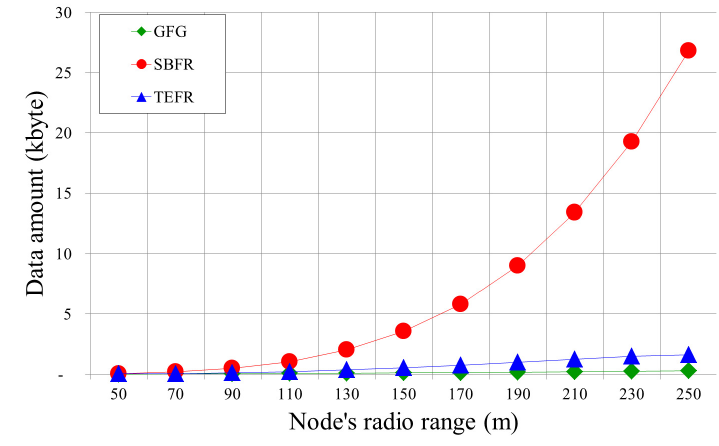
Figure 16. The quantity of transferred location information according to the radio range (Deployed nodes: